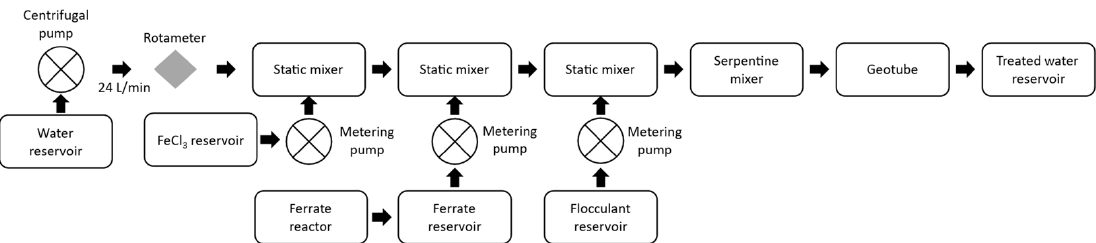
Figure 4. Water treatment plant diagram.